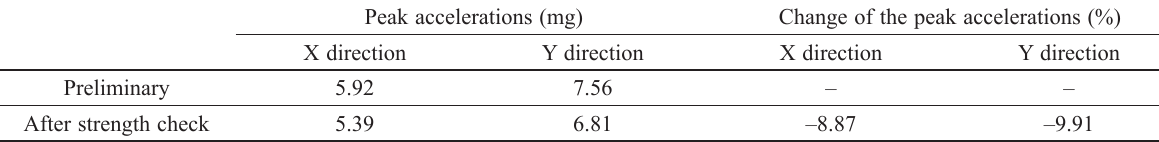
Table 4. The results of the wind-induced response obtained from simplified equations in NBCC Peak accelerations (mg) Change of the peak accelerations (%)